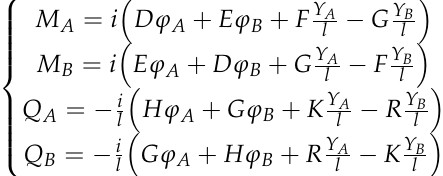
Figure 7. Cable vibration analysis unit.